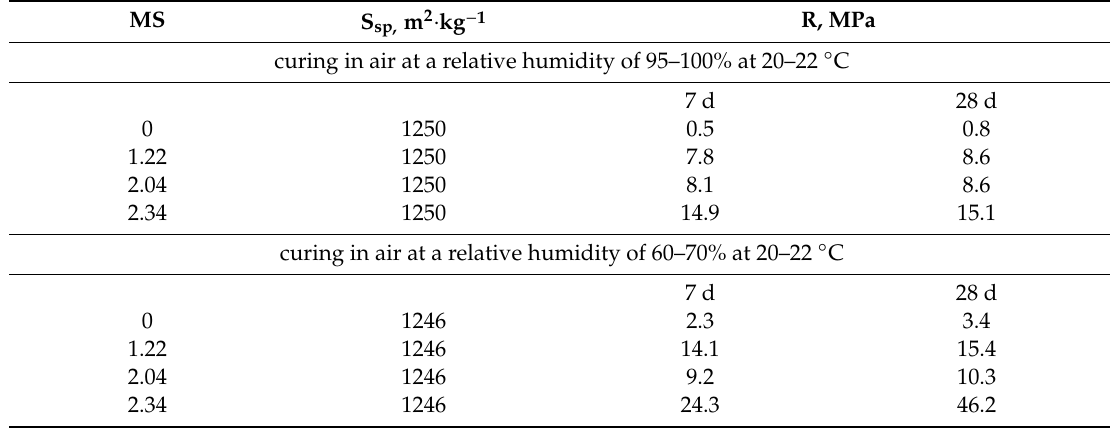
Table 7. The compressive strength (R) of the NT–alkaline agent binder. MA of the NT was carried out in air for 270 s. The percentage of Na 2 O corresponded to the sodium oxide in alkaline agent (liquid glass or NaOH solution) relative to weight of the NT; silica modulus of liquid glass was 1.59 (MS: silica modulus).